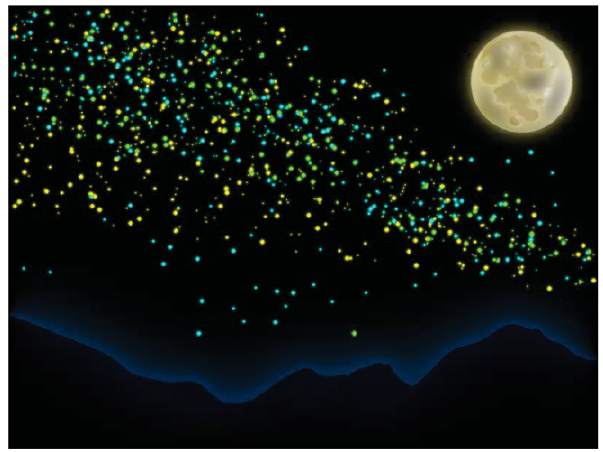
Fig. 11 Starry sky image generated by the DCC model. Using the DCC model, diffusion points can be produced in a unified computational framework.